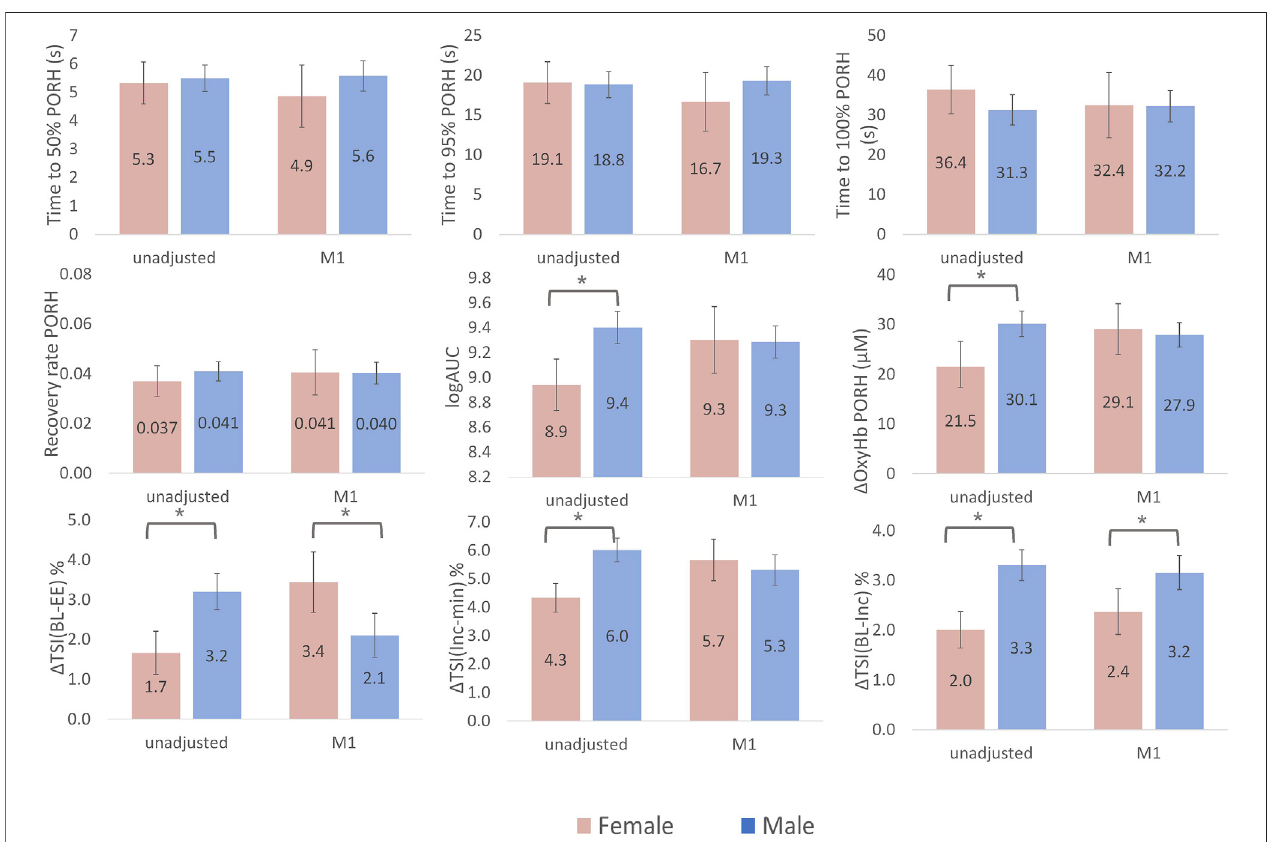
FIGURE2| SexdifferencesinNIRS-measuredskeletalmusclemicrovascularresponsetocuff-inducedischaemiaandexercise.Barsrepresentmarginalmeansfor female (pink) and male (blue). Error bars are 95% con fi dence intervals. Δ TSI BL-EE is the change in tissue saturation index (TSI) between rest (baseline, BL) and the end of exercise (EE); Δ TSI INC-MIN is the change in TSI from it is highest point at the increment (INC) to it is minimum (MIN); Δ TSI BL-INC is the change in TSI from the BL to the highest point (INC). Areaunderthecurve(AUC)had askewed distribution and sologtransformed valuesarepresented. Model1(M1) isadjusted forage,ethnicity, adiposetissuethickness(ATT),height,ischaemicdurationandpresenceoftype2Diabetesandcardiovasculardisease.Thechangeintissuesaturationindex( Δ TSI)from baseline to end of exercise (BL-EE) and Δ TSI from increment to minimum (Inc-min) were additionally adjusted for workload achieved during exercise and the Δ TSI from baseline to the initial increment (BL-Inc) was additionally adjusted for change in mean arterial pressure at the beginning of exercise in model 1.